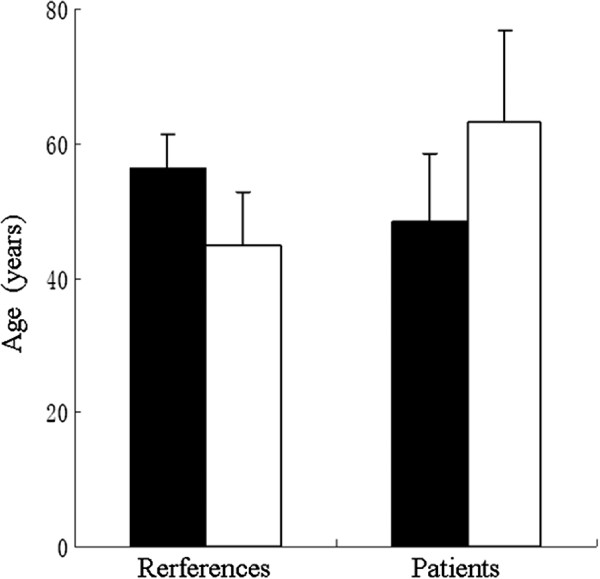
Average ages of glioma patients and controls with SXCI (CR ≥ 3, filled bar) and without SXCI (empty bar). The standard deviations denoted on each bars. The differences in both control and patients are statistically significant (p < 0.05 and 0.005, respectively).